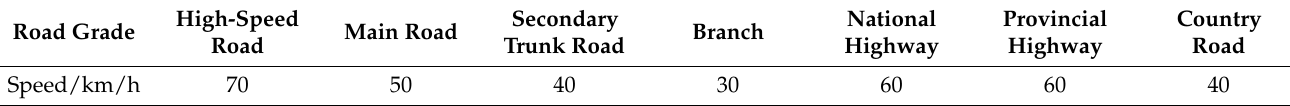
Table 2. The speed of the roads at all